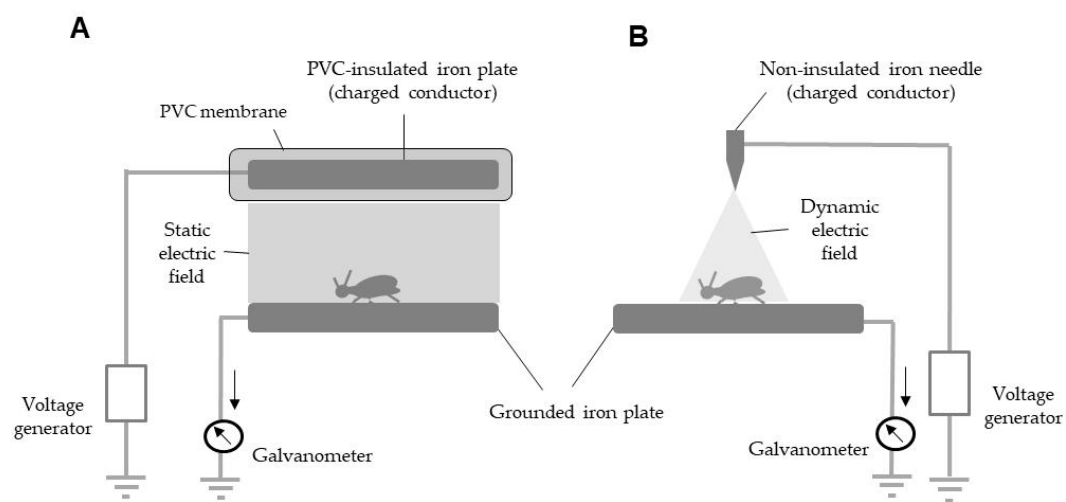
Figure 1. Schematic representations of static ( A ) and dynamic ( B ) electric field producers. Using an insect aspirator, a test insect was transferred onto a grounded plate in the electric field. Arrow indicates direction of electricity movement.